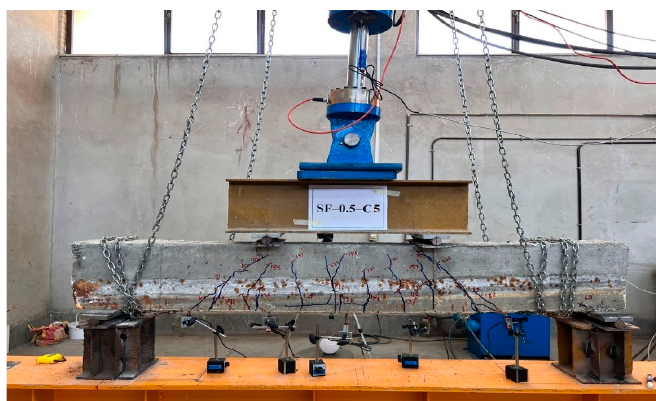
Figure 8. Four-point bending test setup.